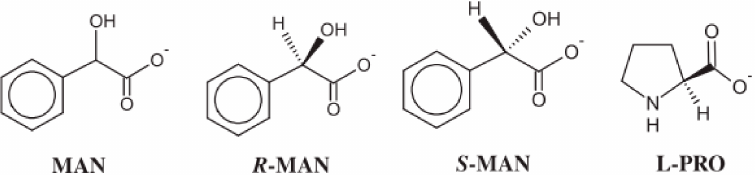
Figure 4. Structures of the anions including racemic mandelate [MAN], R-mandelate [R-MAN], L-mandelate[L-MAN], and L-proline [L-PRO]. Adapted from [21].